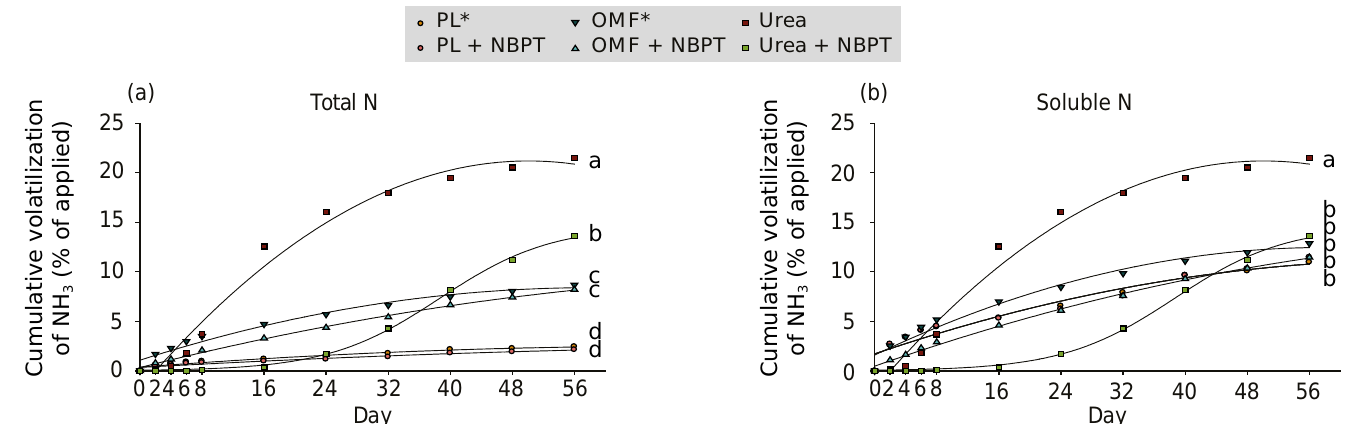
Figure 2. Cumulative volatilization of ammonia following application of 200 mg kg -1 N on the soil surface from nitrogen fertilizers, in the presence or absence of N-(n-butyl) thiophosphoric triamide (NBPT), relatively to the amount of total N (a) or soluble N applied (b). Values were subtracted from those in the treatment that did not receive N fertilizer (control). Treatments followed by the same lowercase letters do not differ by the Tukey test (p<0.05) on cumulative losses of ammonia at 56 days after soil application. PL*: Poultry litter; OMF*: organomineral